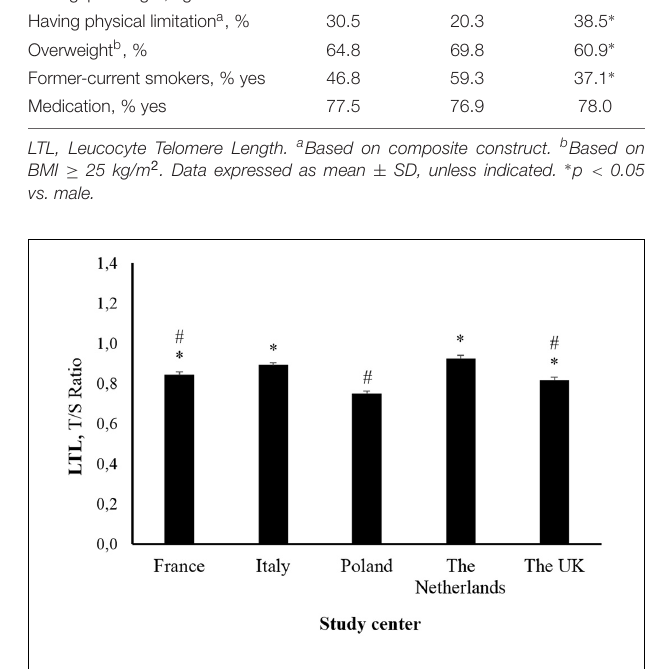
FIGURE 1 | Leucocyte telomere length in older adults across study centers. Data are estimated marginal means ± SE. ∗ p < 0.05 vs. Poland. # p < 0.05 vs.